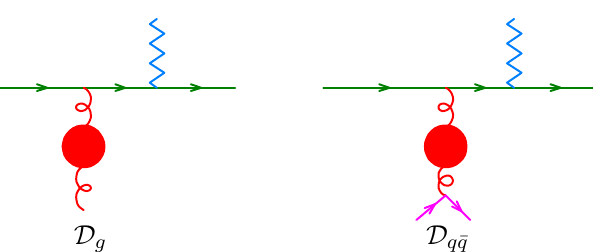
¯ d initiated processes arising as subprocesses in the